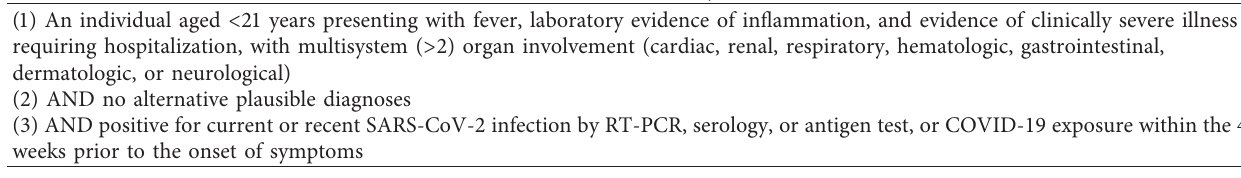
Table 1: Definition of MIS-C by the CDC [6].